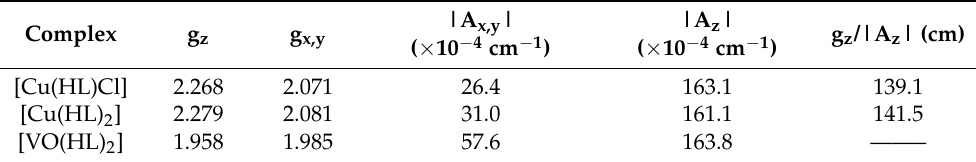
Table 1. Spin Hamiltonian parameters determined by simulation of spectra measured at ca. 100 K [46]. The copper complexes were dissolved in DMF ( ≈ 3 mM), while for vanadium the solvent was methanol ( ≈ 1